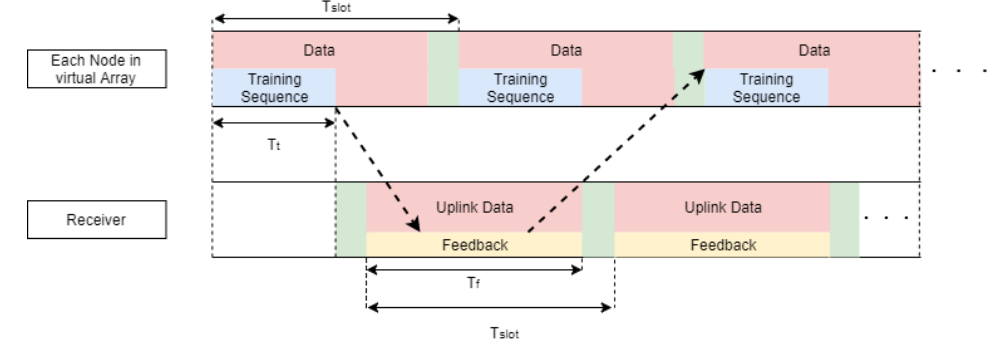
Figure 8. DBS frame structure with a slow feedback